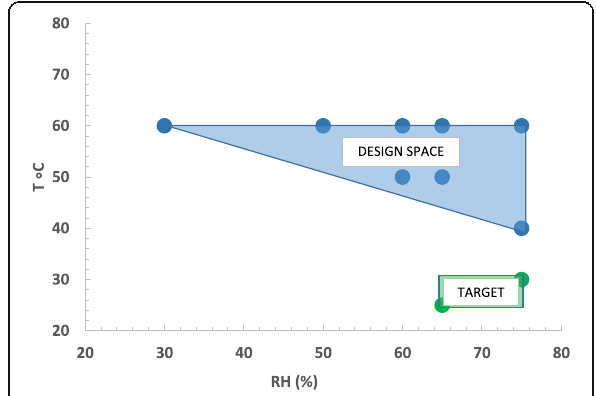
Fig. 2 Design Space showing the Conditions Studied ( blue ) and the Conditions for the Predictions ( green